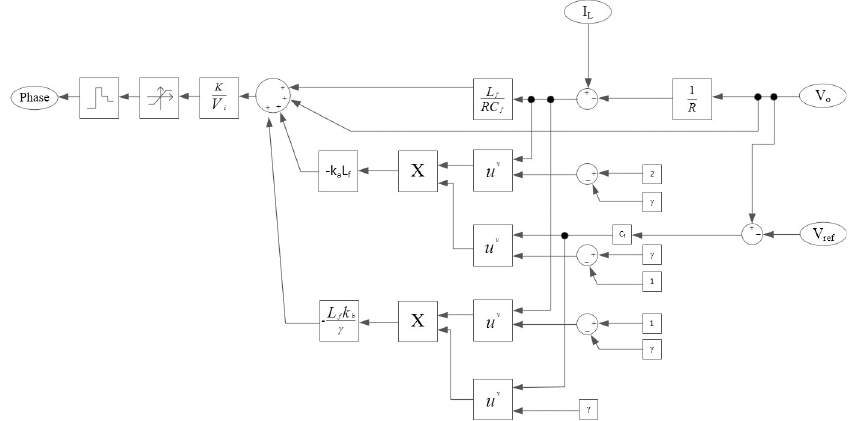
Fig 3. System block diagram of control law u eq